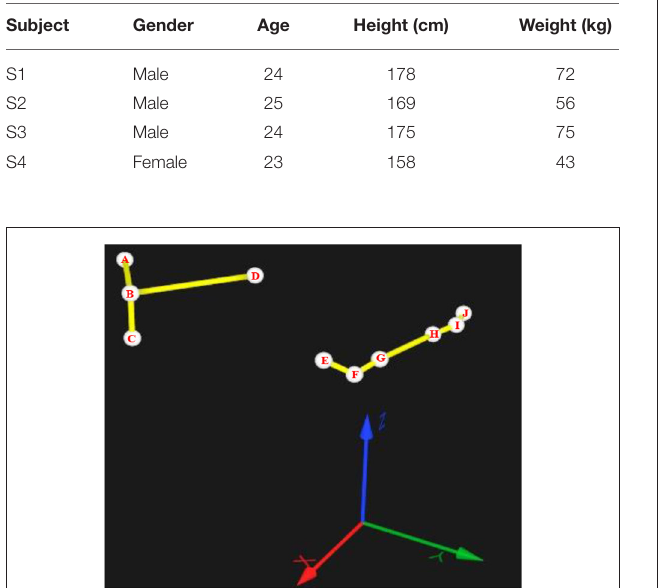
TABLE 1 | Information of the recruited subjects.